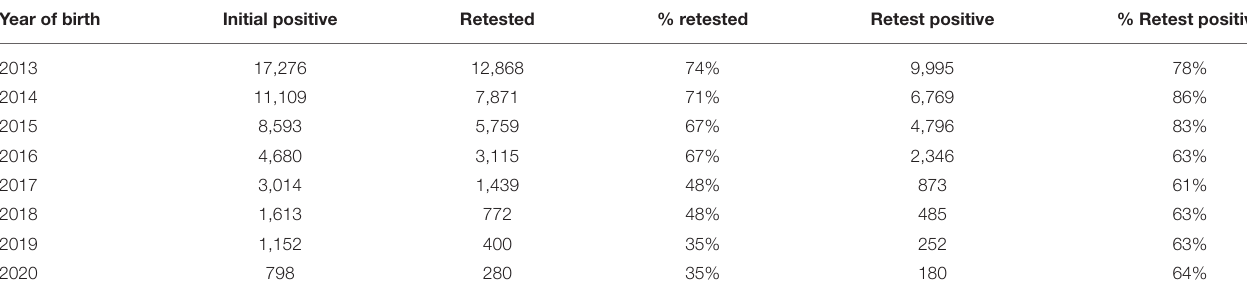
TABLE 5 | Total numbers (%) of calves born each year that were subject to confirmatory testing, and the number (%) confirmed as positive.